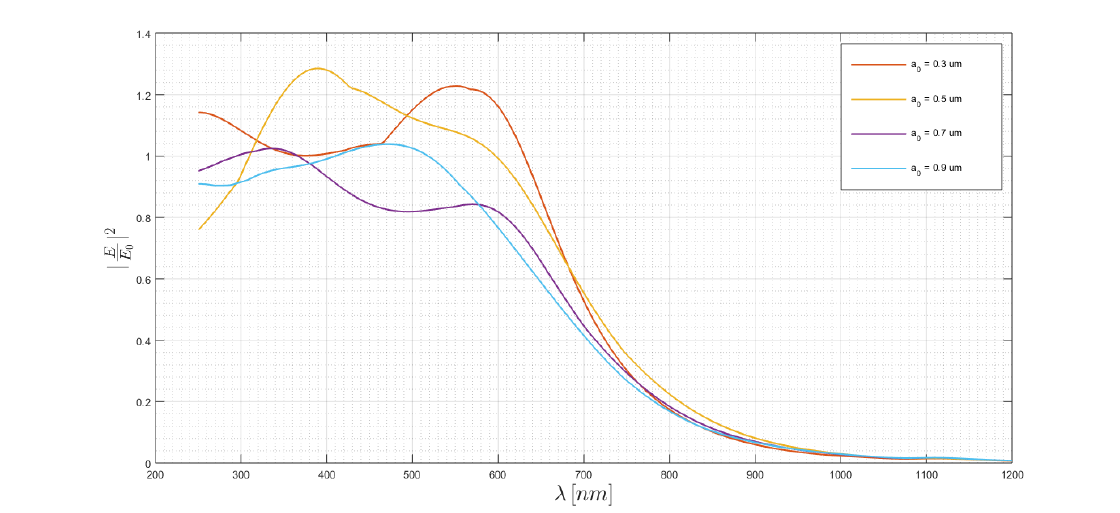
Figure 6. Periodicity sweep on the aluminum